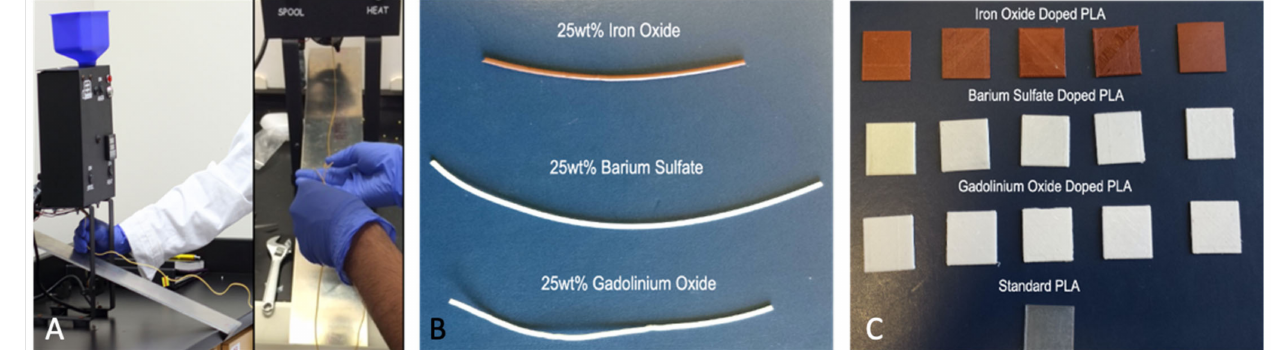
Figure 9. ( A ) Customized printer filament being extruded. ( B ) Photographs of iron oxide, barium oxide, and gadolinium oxide printer filaments. ( C ) Three-dimensionally printed PLA doped squares and standard PLA. Reprinted from